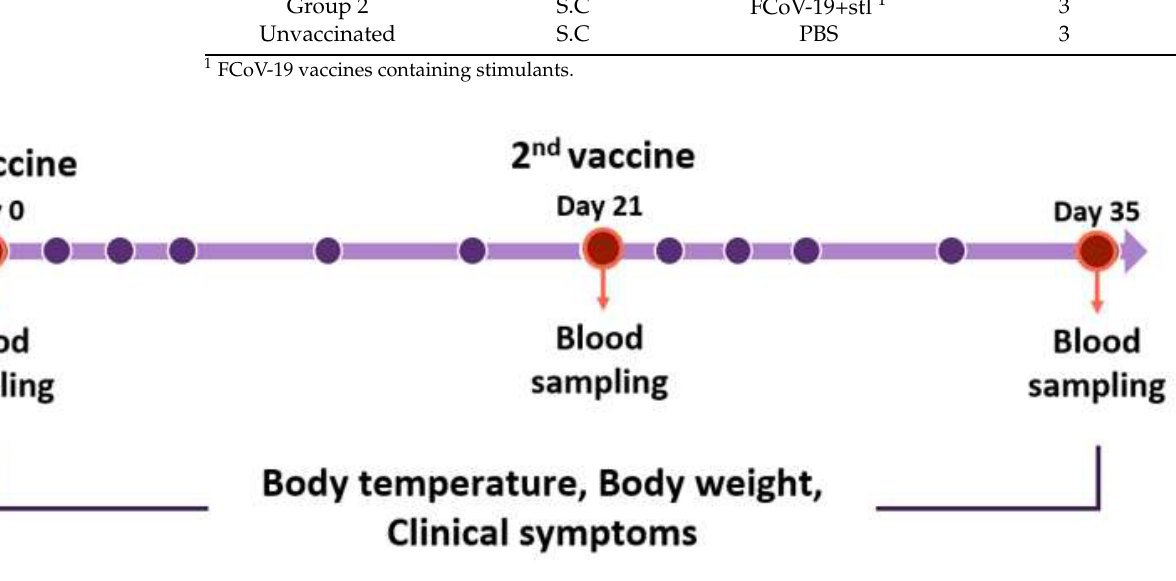
Figure 2. Vaccination schedule for Beagles. Beagles were moored for a week before the experiment. Vaccines were inoculated on day 0, 21, and 35. Blood samplings were performed before vaccination. Body temperature, body weight, and clinical symptoms were measured. The red circles mean the blood sampling date. The purple circles mean the date of checking body temperature, weights, and symptoms for clinical monitoring. All experiments and monitoring were performed by four veteri- narians.